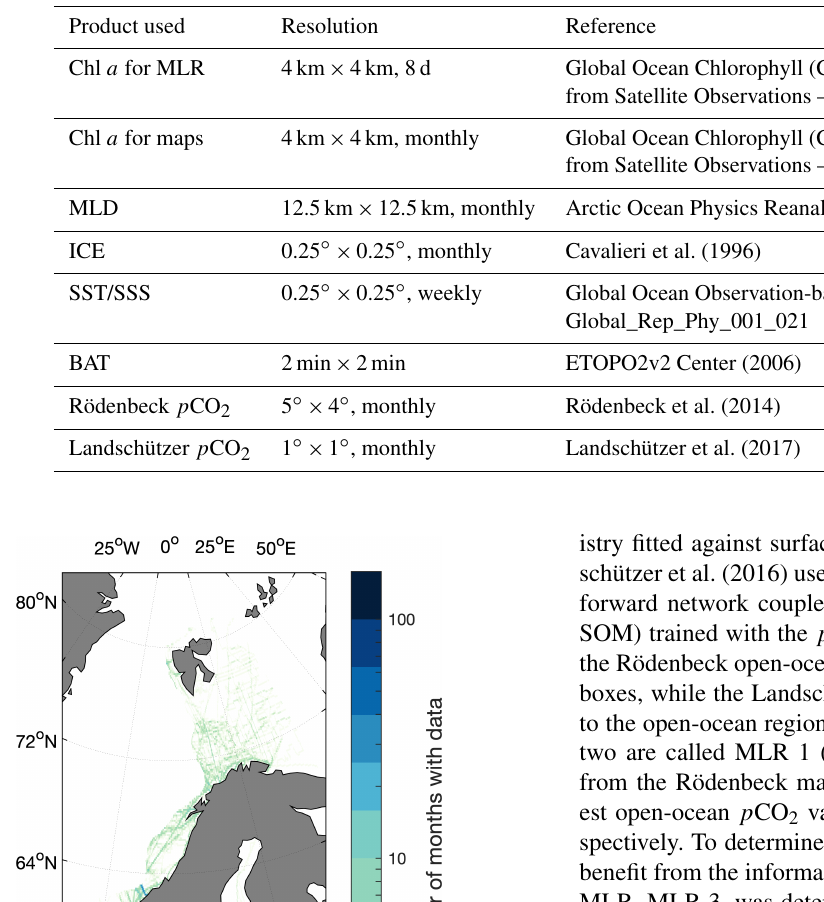
Table 3. Products used as driver data in the MLR and the maps.